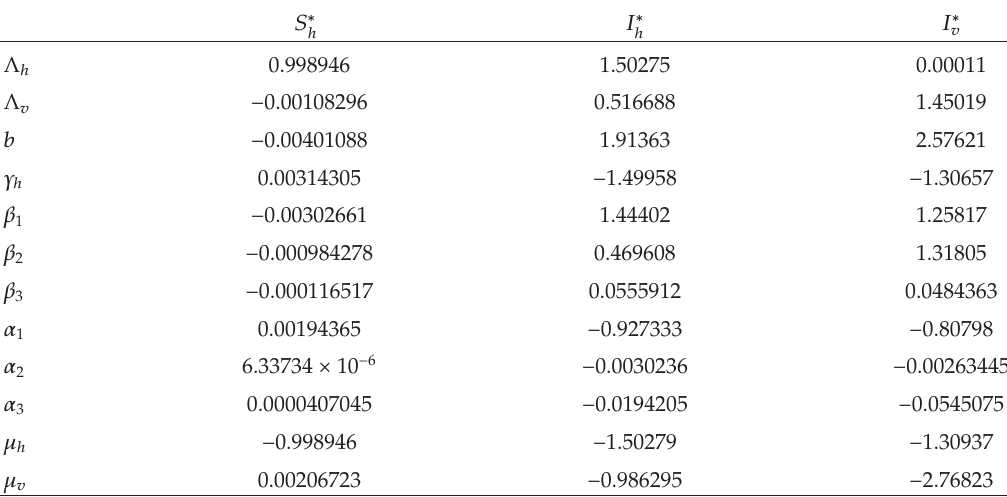
Table 3: The sensitivity indices of the state variables at the endemic equilibrium, x i , to the parameters, p j , for parameter values given in Table